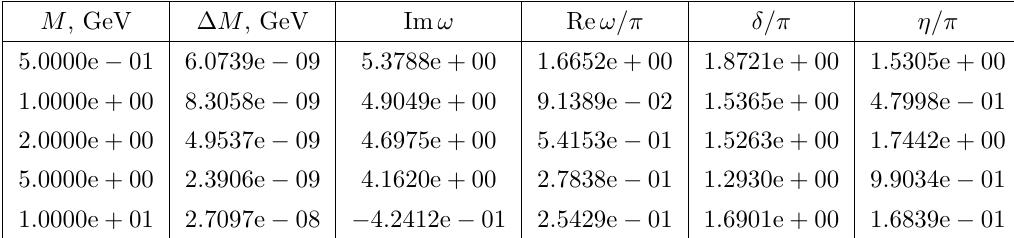
Table 5 . Parameter sets leading to the observed value of the BAU, IH case.